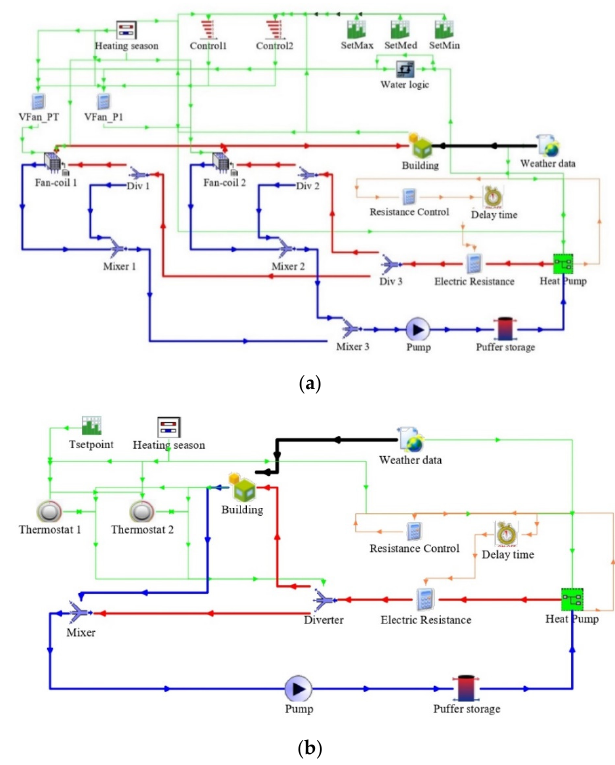
Figure 1. Layout of the heat pump heating systems developed by means of TRNSYS 17 environment: ( a ) based on fan-coils; ( b ) based on under-floor radiant heating.